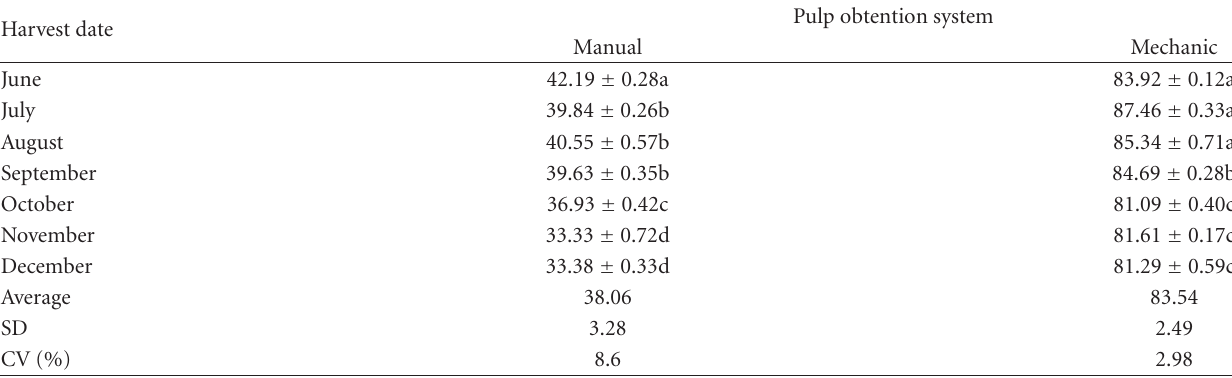
Table 2: Moisture content of the patau´a ( Oenocarpus bataua Mart.) fruits harvested in the Adolpho Ducke Forest Reserve, in Manaus, Amazonas, Brazil.